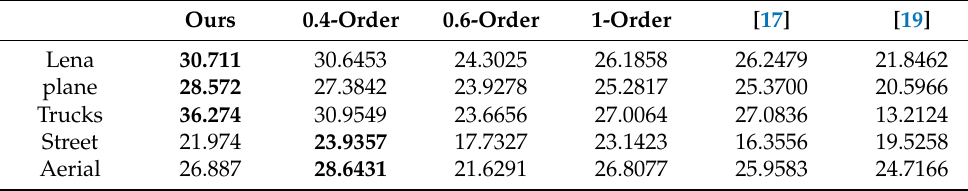
Table 2. Under different algorithms, the PSNR values of different images.